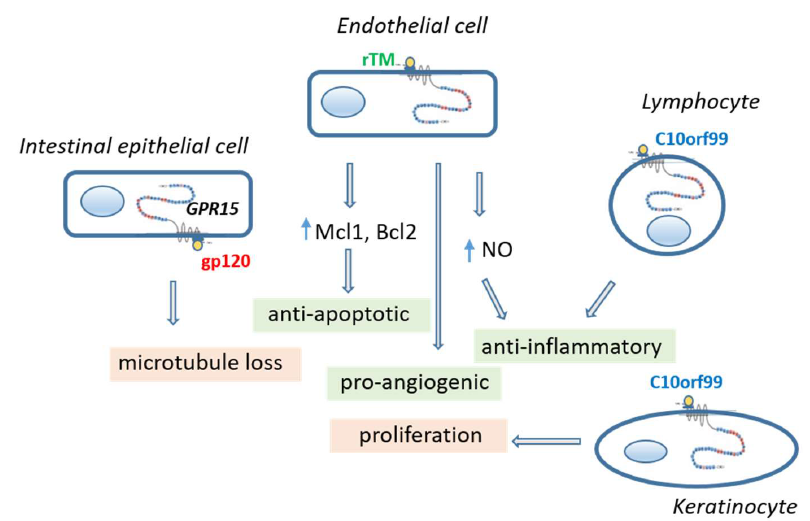
Figure 2. Consequences of GPR15 activation in different cell types by different agonists. Activation of GPR15 in vascular endothelial cell and lymphocytes leads to a greater cell-protecting effect. In contrast, activation of the intestinal epithelial cells by gp120 of HIV causes leakage in the epithelial layer and activation of keratinocytes by C10orf99 causes adverse proliferation. C10orf99 chromosome 10 open reading frame 99, gp120 glycoprotein 120 of human immunodeficiency virus, GPR15 orphan G protein-coupled receptor 15, Mcl1/Bcl2 anti-apoptotic proteins, NO nitric oxide, r TM recombinant thrombomodulin.